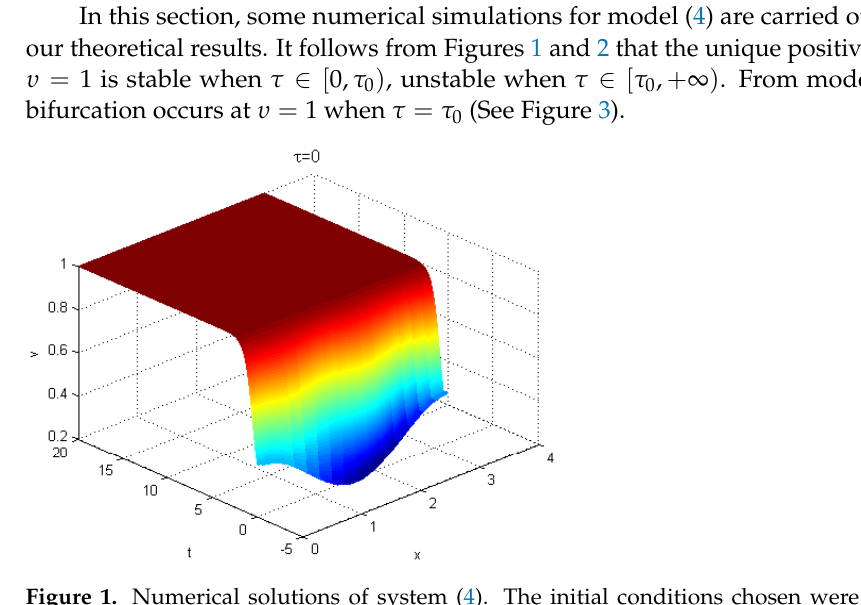
Figure 1. Numerical solutions of system (4). The initial conditions chosen were the following: v 0 = 0.25cos 2 x + 0.2. The parameters chosen were the following: m ( x ) = 1, K ( x ) = sin ( x ) + 2, α = 1, d = 2, τ = 0 < τ 0 ≈ 0.75.